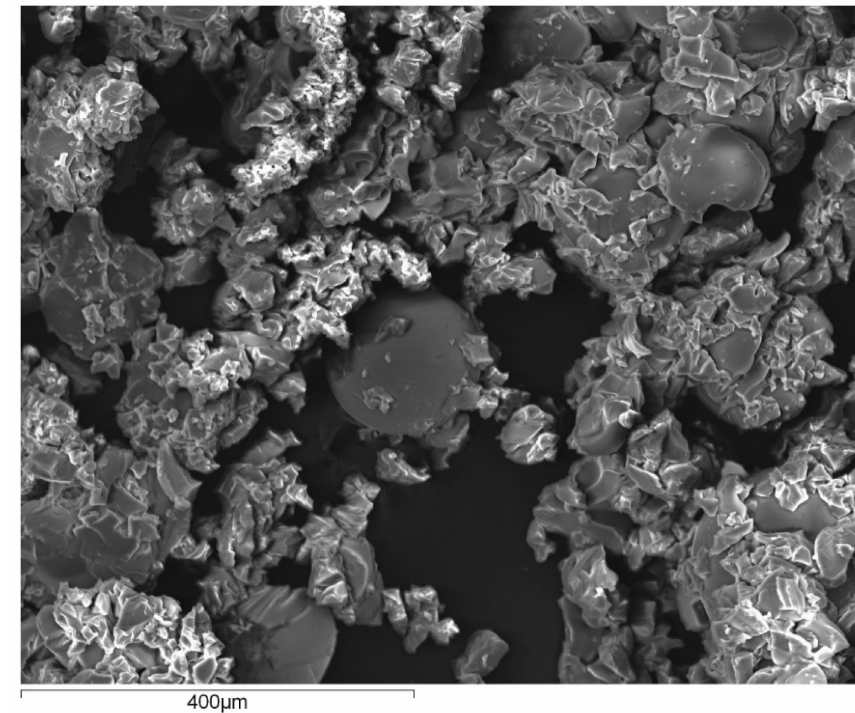
Figure A4. SEM image of PEGMA-AMP-3 (magnification ×